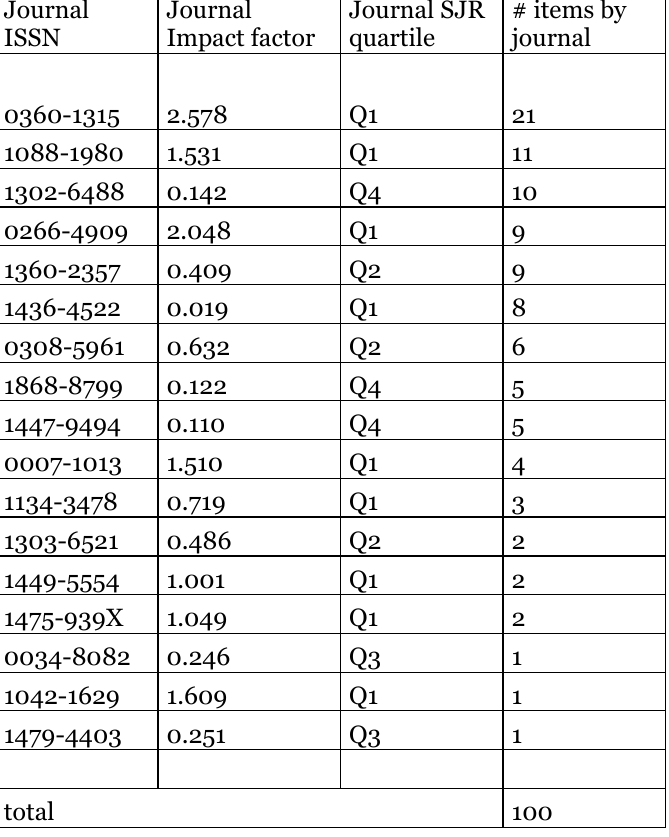
The last filtering was carried out through an abstracting proccess that allowed reducing the document set to a final group of 100 items, ready for further in-depth reading as shown in table 1. Table 1 Final Set of 100 Items for In-Depth